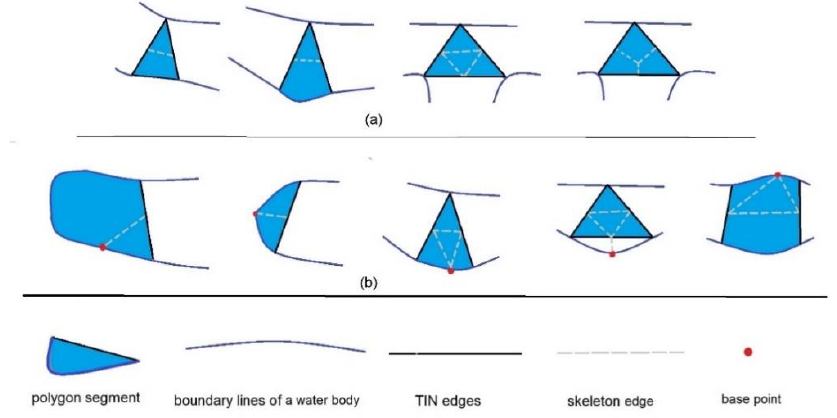
Figure 8. Editing of skeleton edges based on various types of polygon segments: ( a ) different types of polygon segments with skeleton edges; ( b ) different locations of base points in segments with a visualization of skeleton edges.